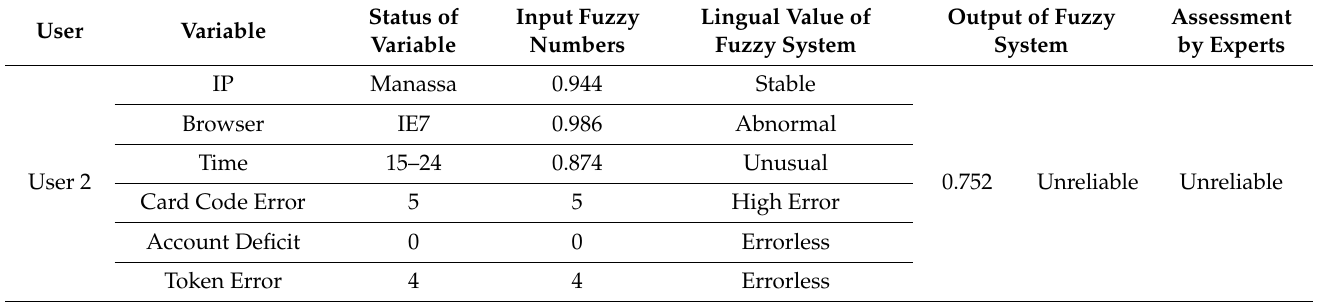
Table 14. Status of variables for User 2 (source: research analysis).